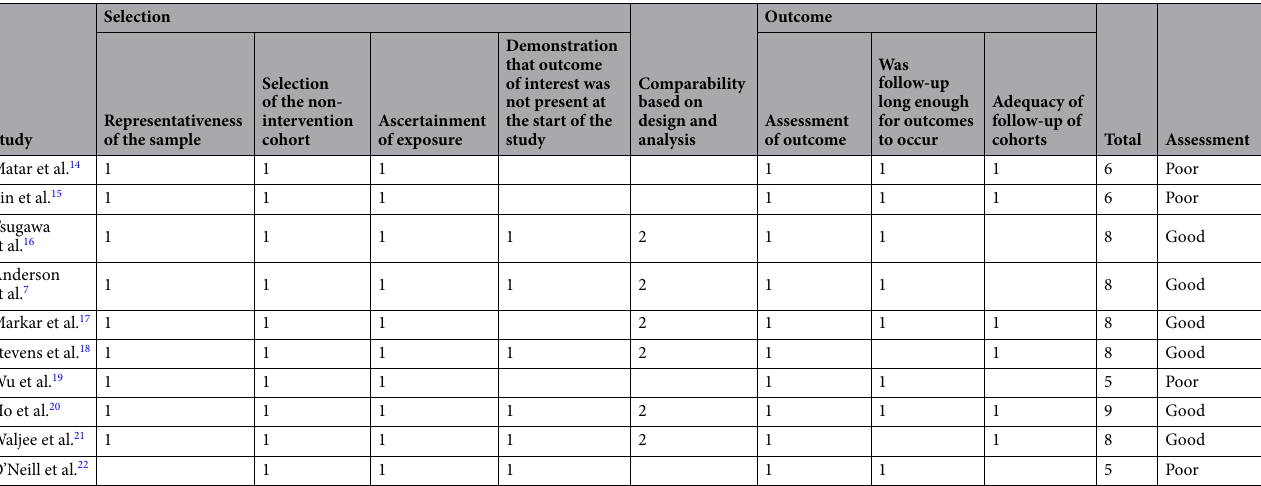
Table 3. Quality assessment of included studies. Good quality: 3 or 4 stars in selection domain AND 1 or 2 stars in compatibility domain AND 2 or 3 stars in outcome/exposure domain, Fair quality: 2 stars in selection domain AND 1 or 2 stars in comparability domain AND 2 or 3 stars in outcome/exposure domain, Poor quality: 0 or 1 star in selection domain OR 0 stars in comparability domain OR 0 or 1 stars in outcome/ exposure